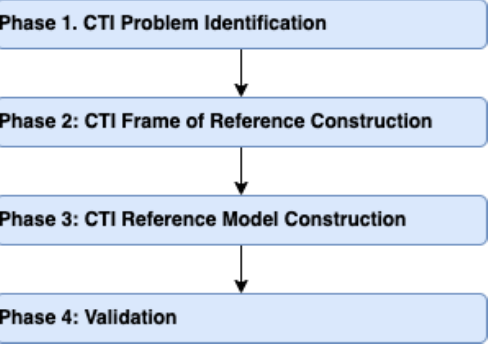
Figure 2. CTI Reference Model Design